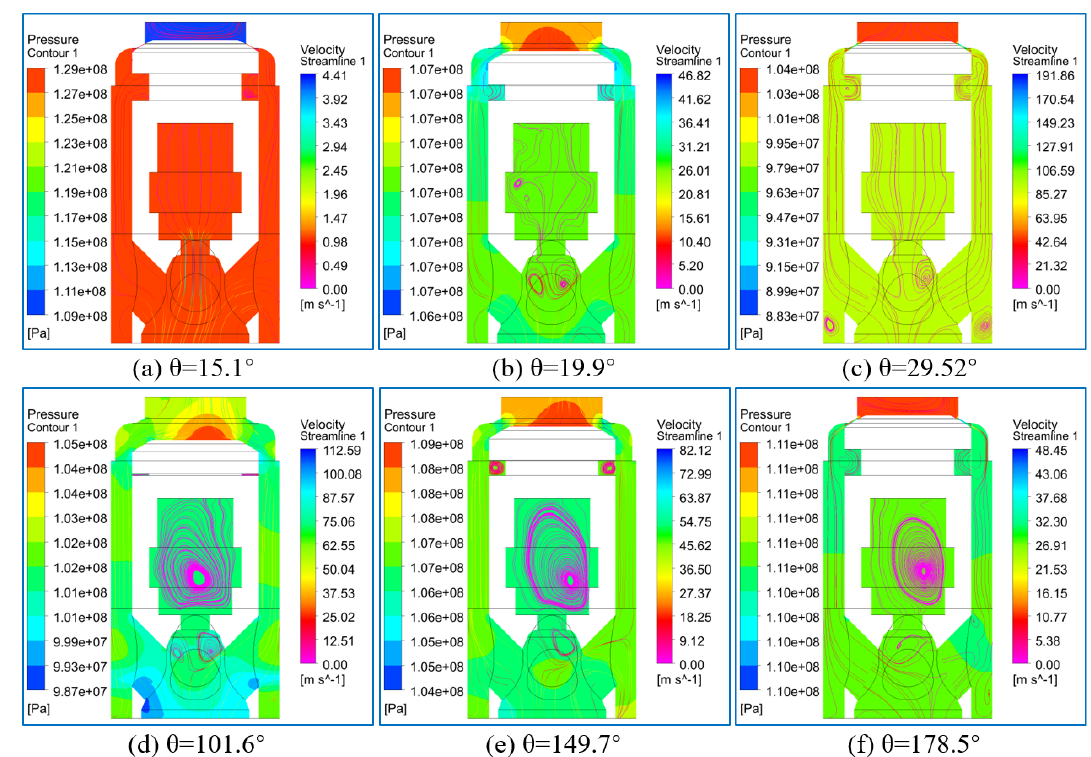
Figure 13. Pressure and velocity distribution during the opening process of the suction valve.